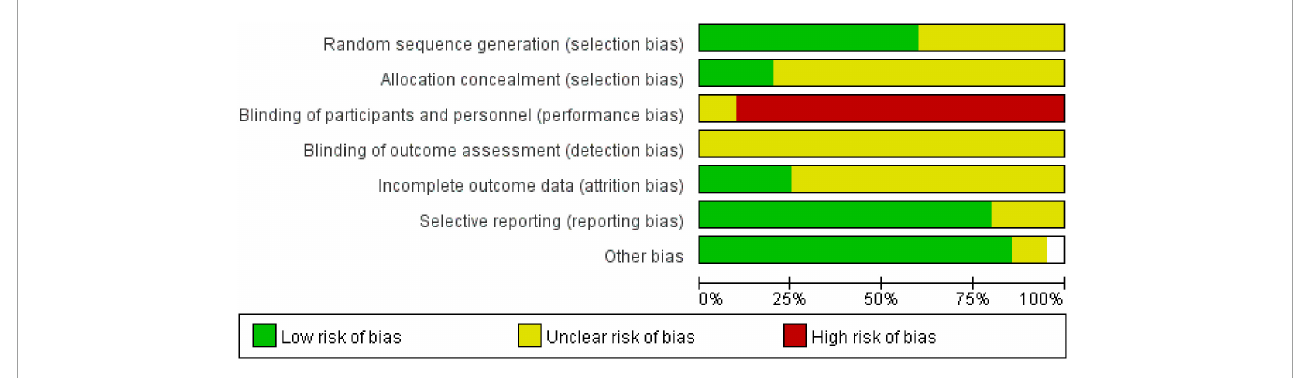
FIGURE2 Risk of bias in included